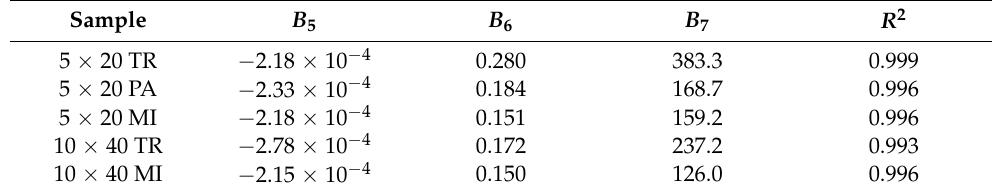
Table 6. The values of coefficients B 5 , B 6 , B 7 and R 2 from Equation (22) obtained for individual samples.